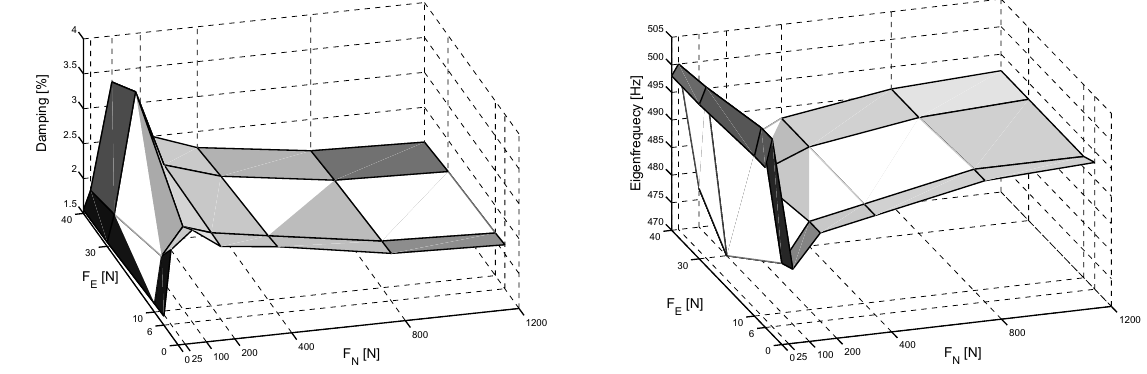
Fig. 8. Modal damping and eigenfrequency for the work piece table with friction beam at one side – mode 1.